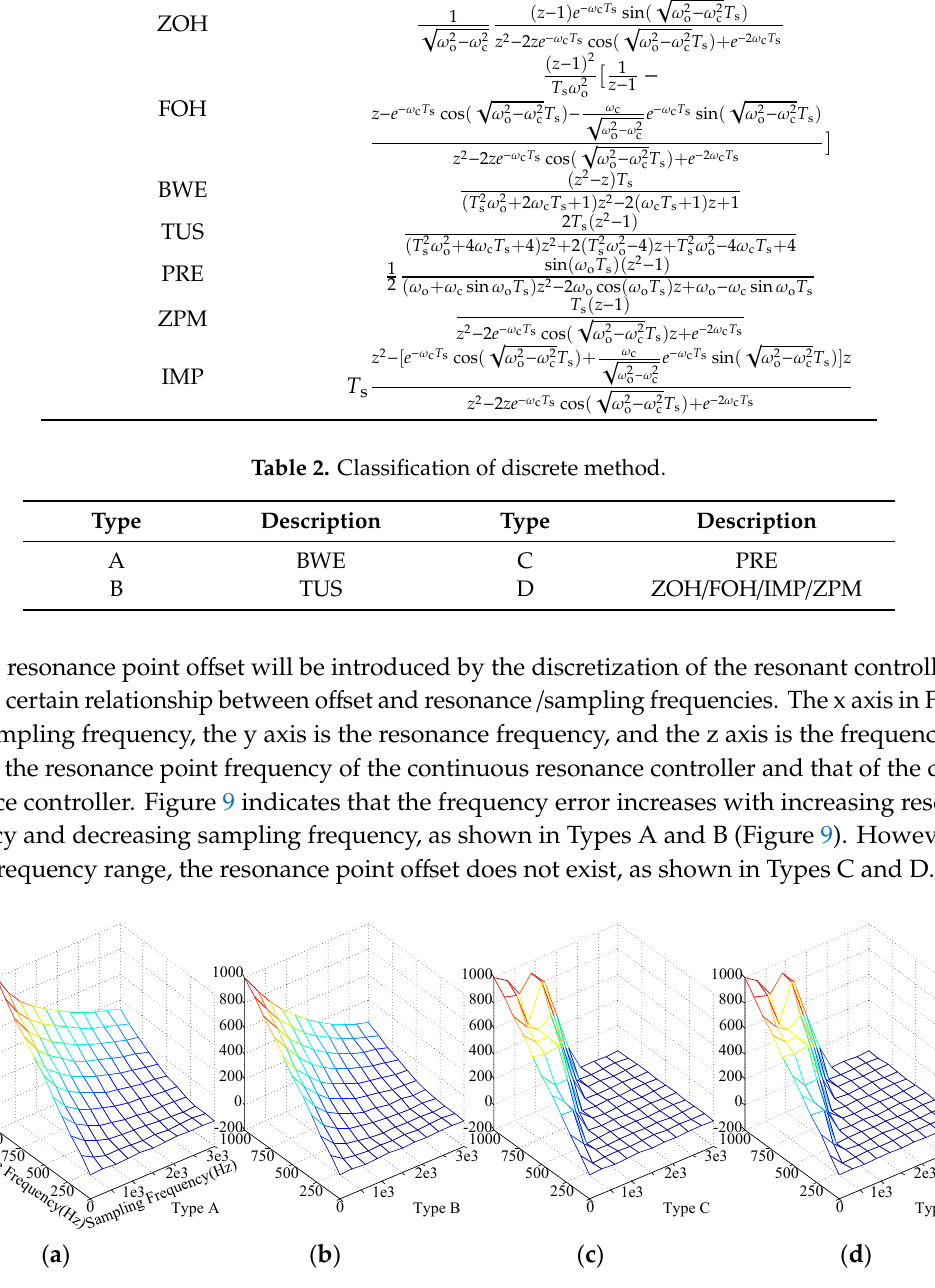
Figure 9. Figures of three-level error of resonance point. ( a ) Type A; ( b ) Type B; ( c ) Type C; ( d ) Type D.